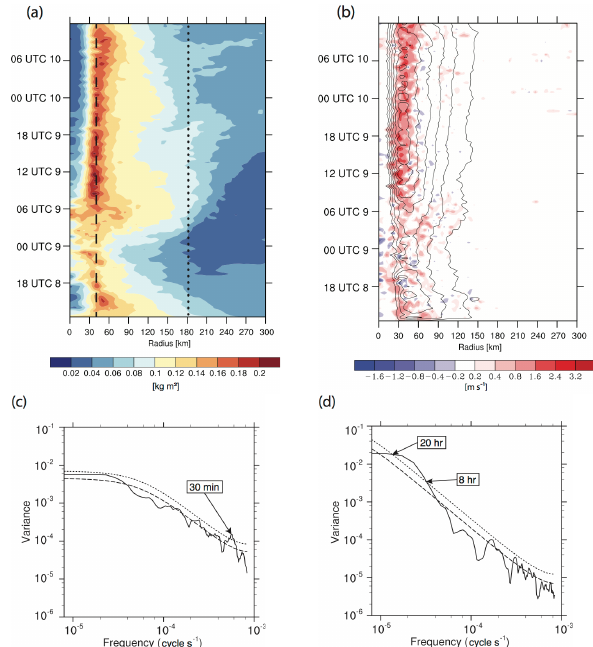
Fig. 4. (a) Hovmöller diagram of azimuthally averaged precipitable water (PW) in the simulation of typhoon Saomai. Dashed and dot- ted lines in (a) denote locations of spectral analyses performed in (c) and (d) , respectively. (b) The same as in (a) except for the verti- cal velocity (color) at 1.5kma.g.l. superimposed on the horizontal wind speed at 1.5kma.g.l. from 25 to 50ms − 1 with 5ms − 1 in- tervals. The power spectrum of PW with respect to frequency are shown at (c) 40km and (d) 180km from the typhoon center. Dashed and dotted lines in (c) and (d) represent red noise and the 95% con- fidence level,